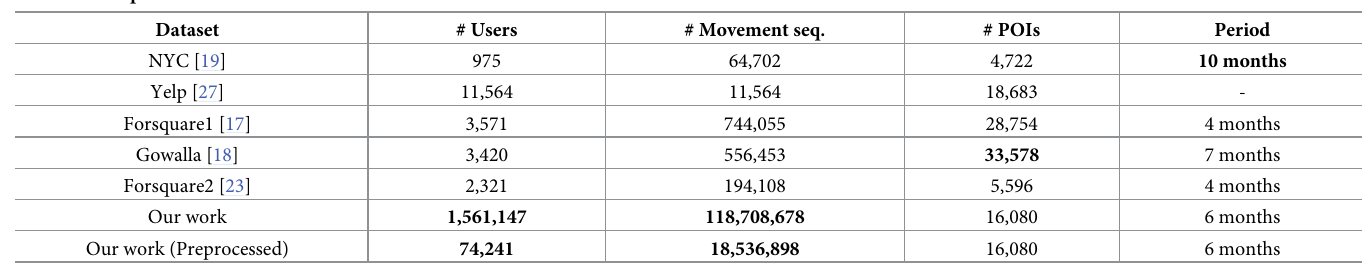
Table 2. Comparison of datasets.